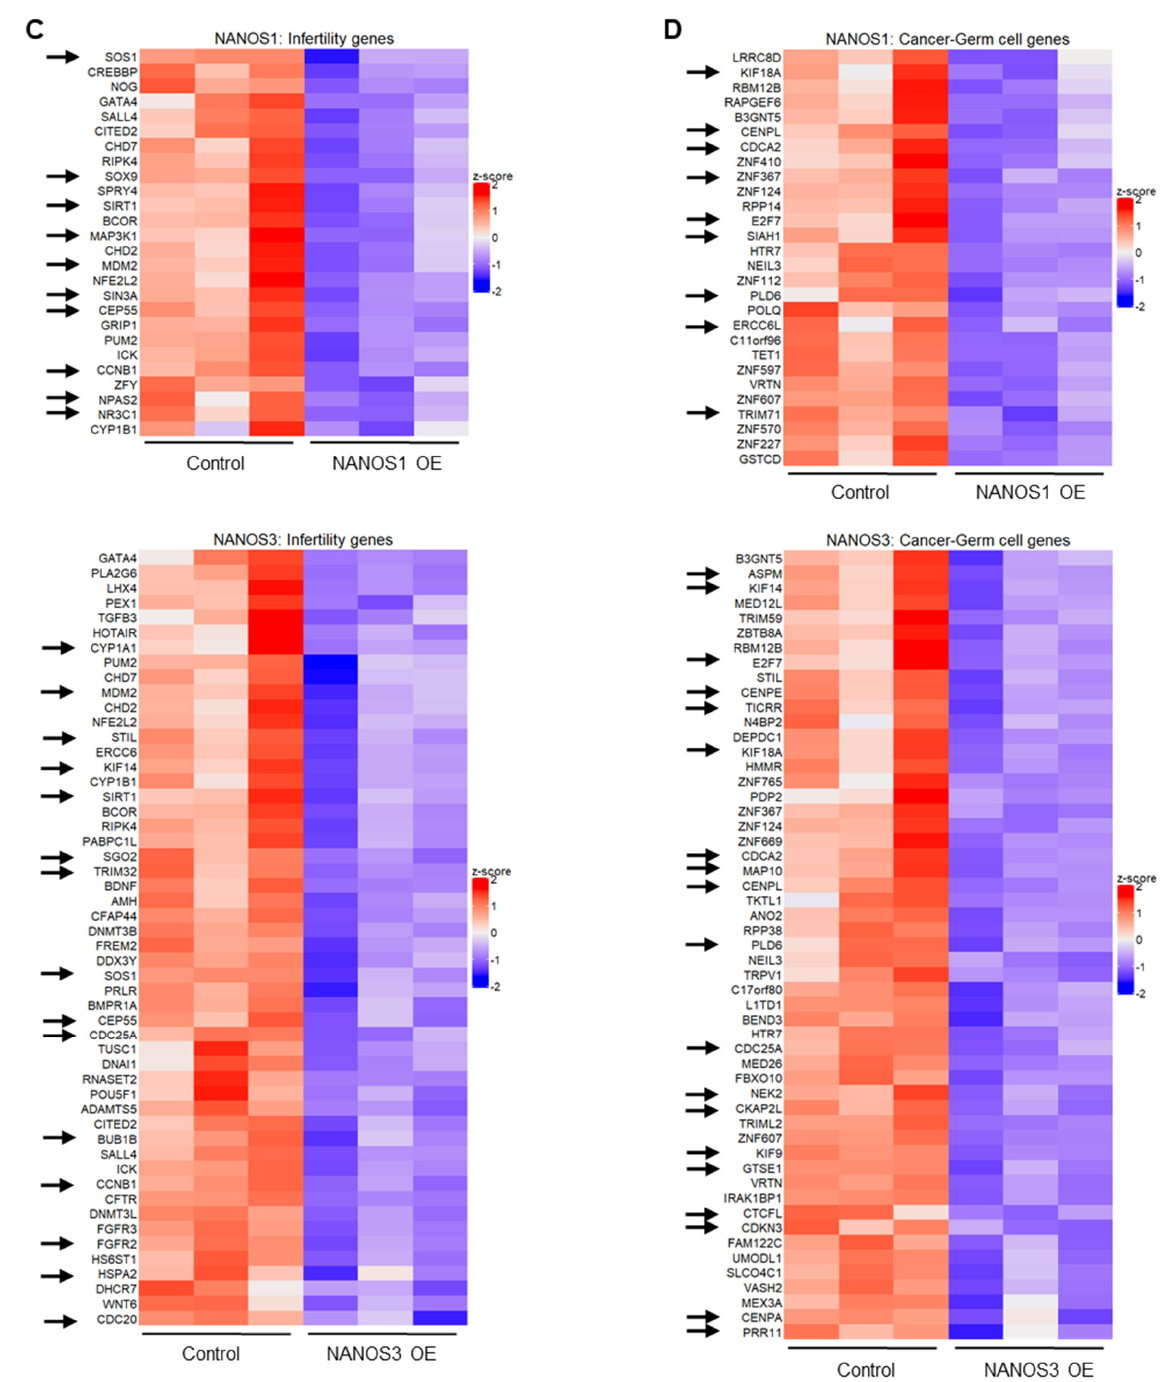
Figure 1. Transcriptomic changes upon NANOS1 and NANOS3 overexpression in TCam-2 cell line. ( A ) RNA-Sequencing (RNA-Seq) upon NANOS1 (left panel) and NANOS3 (right panel) overexpression visualized as MA-plots. Differentially expressed genes were filtered with log2FC ≥ 0.5 for upregulated and ≤ − 0.5 for downregulated genes. Adjusted p -value ≤ 0.01 was considered as significant. ( B ) Venn diagram showing common and distinct differentially expressed genes between NANOS1 and NANOS3 overexpression. ( C ) Expression level of infertility genes downregulated upon NANOS1 (upper heatmap) and NANOS3 (lower heatmap) overexpression visualized as heatmaps with z-score scaling. ( D ) Cancer-germ cell genes downregulated upon NANOS1 (upper heatmap) and NANOS3 (lower heatmap) overexpression. Genes involved in cell cycle are marked by